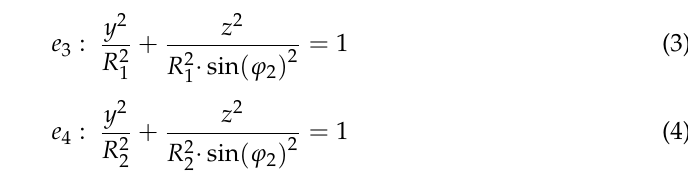
Figure 5. Representation of the four ellipses used to construct the section of the workspace ( 𝑒 (cid:2869) —red, 𝑒 (cid:2870) —orange, 𝑒 (cid:2871) —black, 𝑒 (cid:2872) —blue).